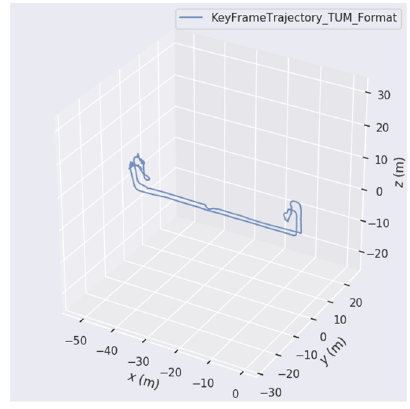
Figure 15. Building positioning track map.